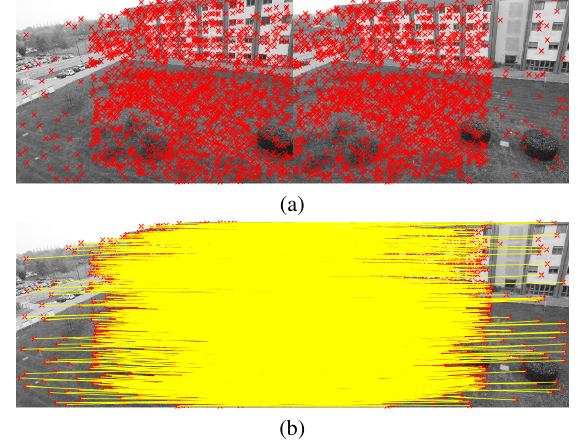
Figure 3. Feature matching (and outlier removal) based on the estimation of the epipolar geometry. (a) matches between the two images. (b) matched features linked with yellow